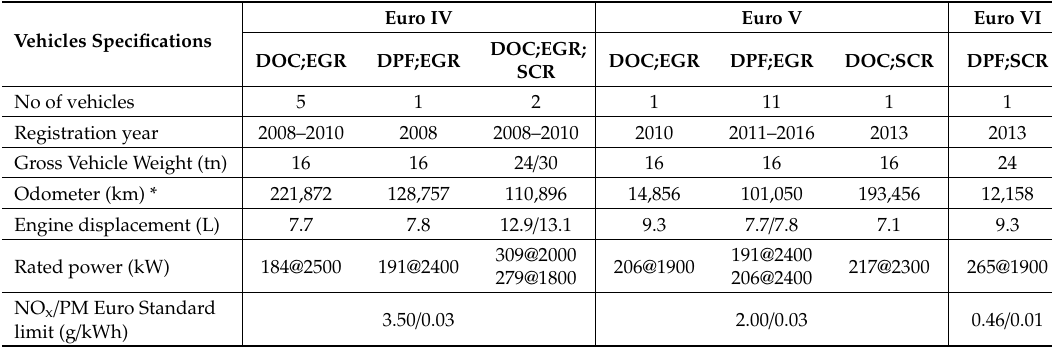
Table 1. Vehicles